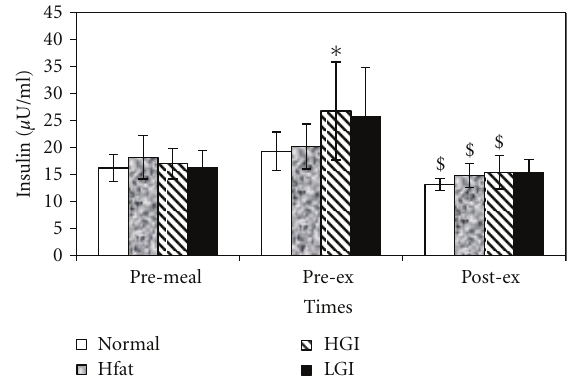
Figure 3: Mean ( ± SE) plasma 3-OHB concentrations at pre-meal, pre-exercise and, post-exercise for four trials. ∗ indicates significant with resting values.